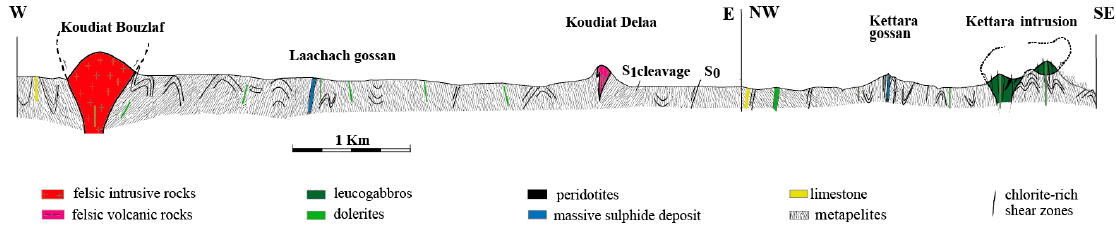
Figure 3. Cross-section through the western and central massive sulphide lineaments (see location in Figure